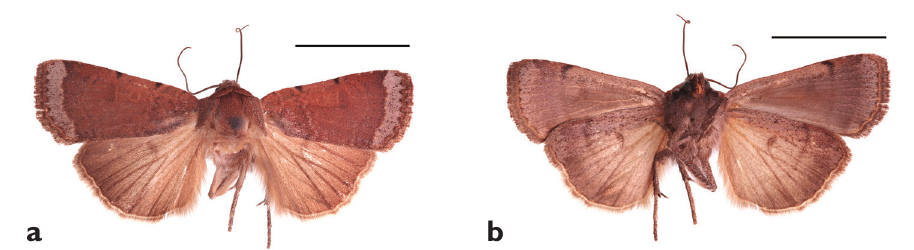
Figure 15. Abagrotis nefascia (Smith), Yakima, WA. P. Landoldt. a Dorsal b Ventral. Scale bars: 1 cm (Photos B. Proshek).